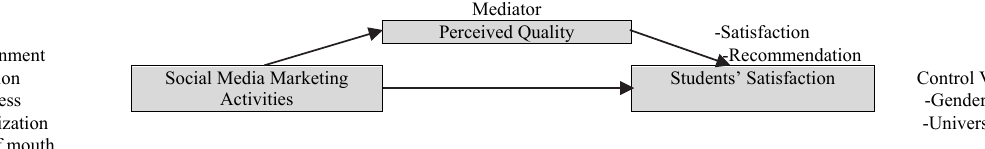
Fig. 1. The structure of the proposed